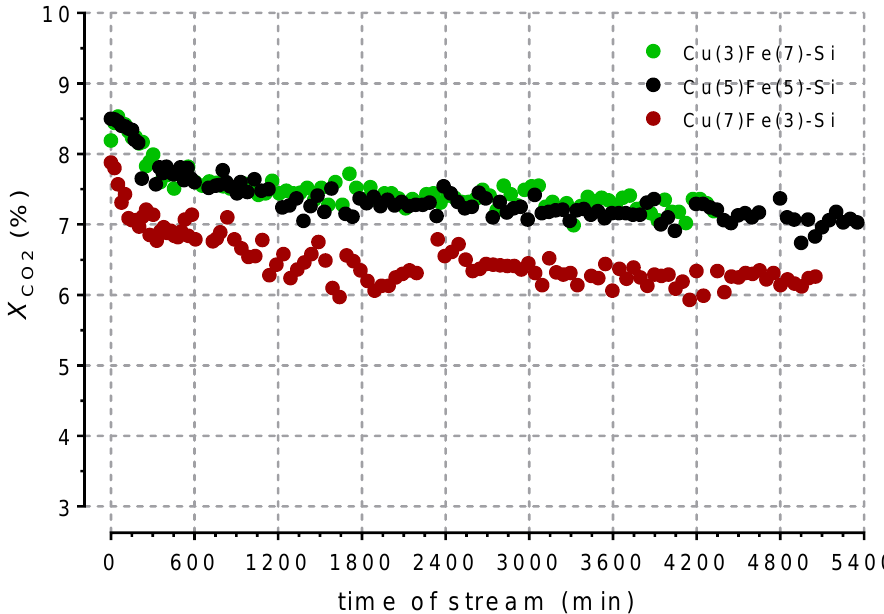
Figure 9. Trend of CO 2 conversion ( X CO2 ) with time on stream. Reaction conditions: P R , 30 bar; T R , 260 °C; CO 2 /H 2 /N 2 : 3/9/1; GHSV: 8800 N L/kg cat /h; tos, 5400 min.